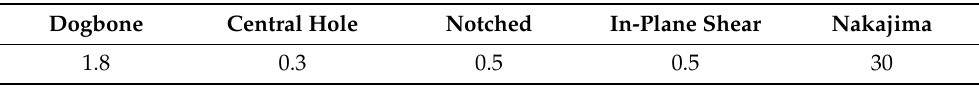
Table 3. The crosshead velocity for different specimens in order to obtain quasi-static loading conditions (mm/min)